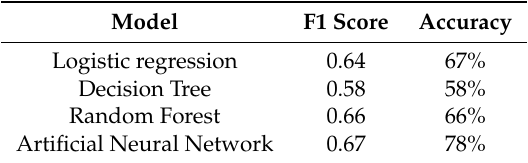
Figure 7. F1 score of artificial neural networks on unbalanced and augmented narratives. Table 2. Accuracy and F1 score for all the models (fixed field entries).